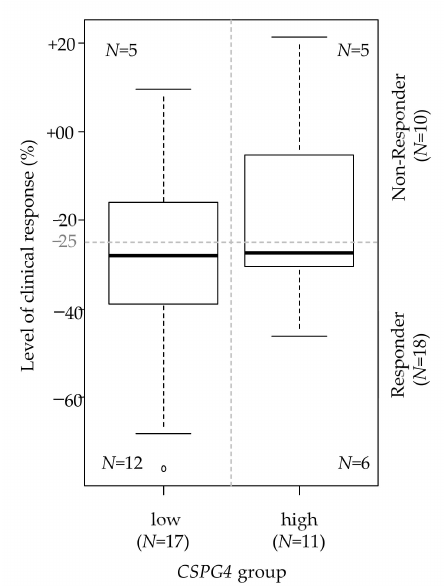
Figure 1. Disease-free survival in patients with localized GIST after surgery. ( A ) Kaplan-Meier DFS curves in the 87 informative patients for DFS. ( B ) Similar to ( A ), but according to CSPG4 expression (low and high). The p -value is for the log-rank test.